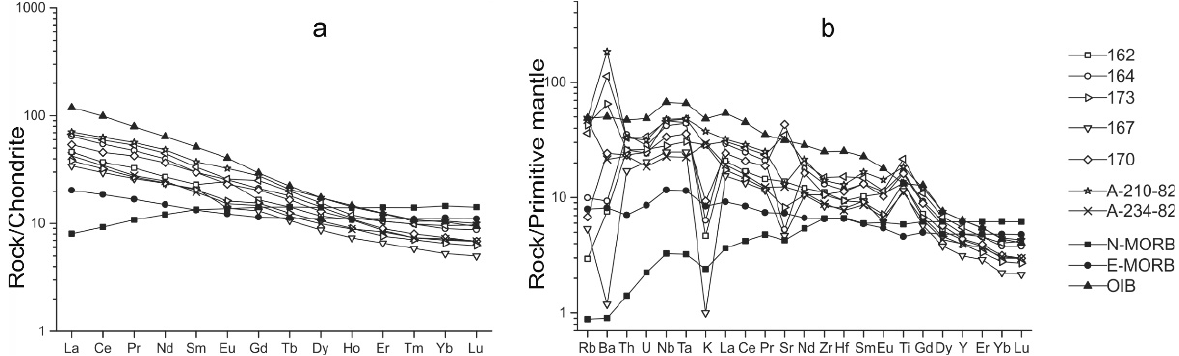
Figure 19. Chondrite-normalized REE patterns [98] ( a ) and primitive mantle-normalized spider- grams [99] ( b ) for metabasites of the Angara region compared to the main types of basalts: N-MORB, E-MORB and OIB after [99]. Numbers in symbols correspond to the sample numbers.